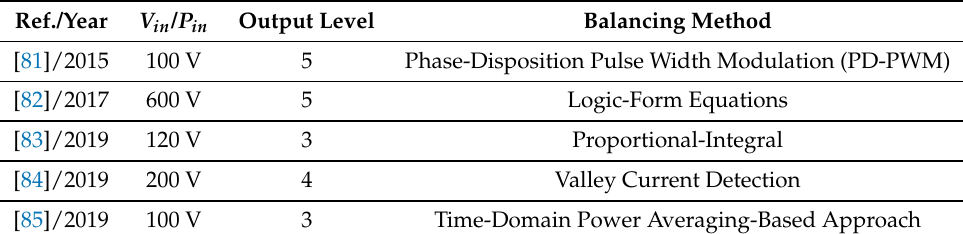
Table 9. Recent work on voltage balancing in